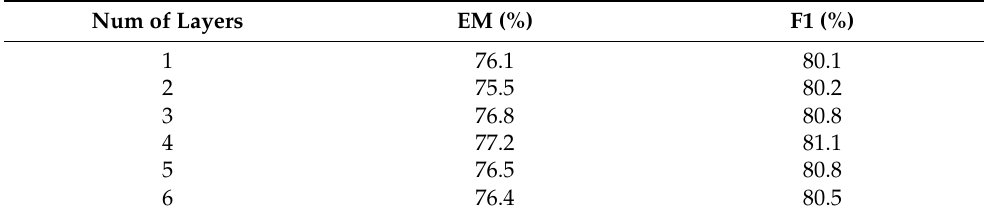
Table 4. Impact of the number of dependency layers on the performance of the